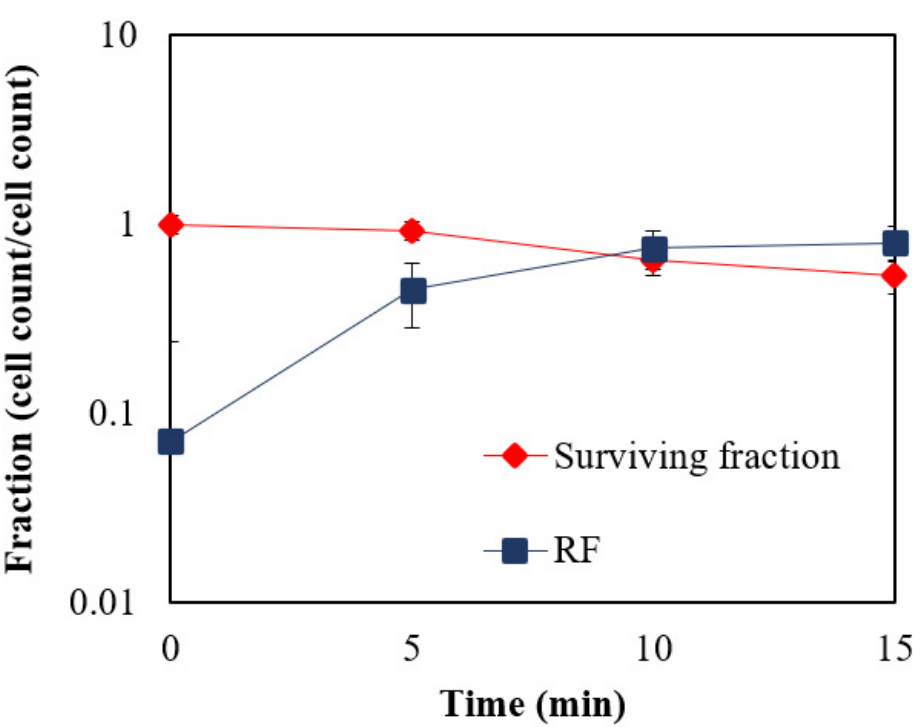
Figure 6. CbCt surviving fraction and relative frequency of induced mutation from UV exposure. The cell count trend obtained after mutation with UV and EMS indicates that loss of cell viability was lower for prolonged (60 min) EMS mutation (70% cell death) than for UV exposure (30 min), where it was significant (93% cell death). The RF, however, was much higher for UV than for EMS. A similar trend has been noticed in previous studies [27]. This was explained by the different mechanism of mutations caused by UV and EMS, where UV mutation is an indirect mutation caused by the misrepair of DNA thus causing heavy DNA damage, whereas EMS causes direct point mutation without as heavy collateral DNA damage [34]. The mutated strains showing the highest relative frequencies and tolerance to biobutanol for both UV and EMS mutagenesis were selected and the production from SSF of WS was investigated. SSF was conducted for 120 h.